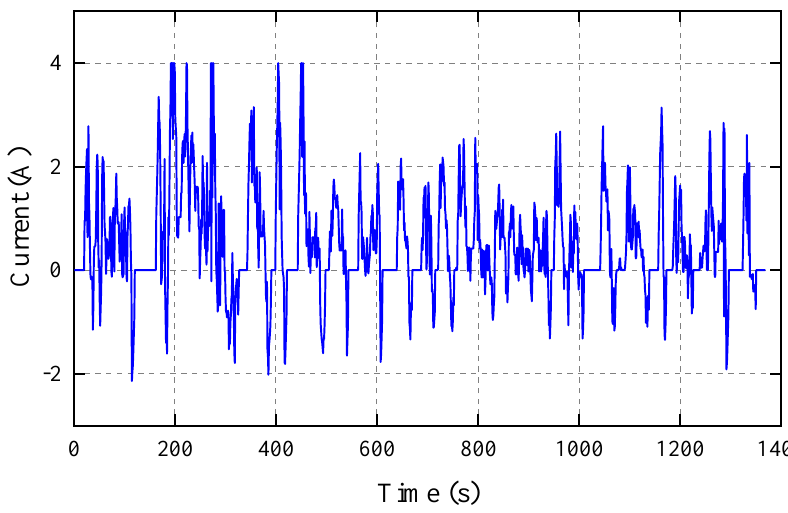
Figure 8. Battery current excitation curve under the FUDS working condition. The battery SoC estimation and error results of the four algorithms are shown in Figures 9–12.